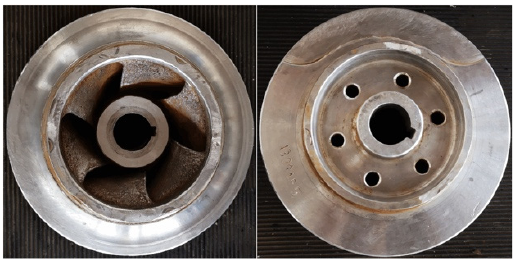
Figure 5. Schematic of the current experimental system ( a ), and a picture of this system in the lab ( b ).